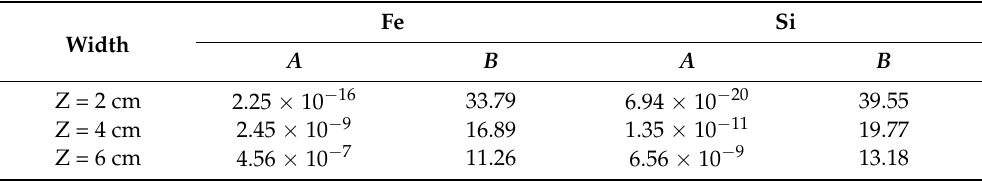
Table 4. The relationships between A and B and the width of the molten zone. Width